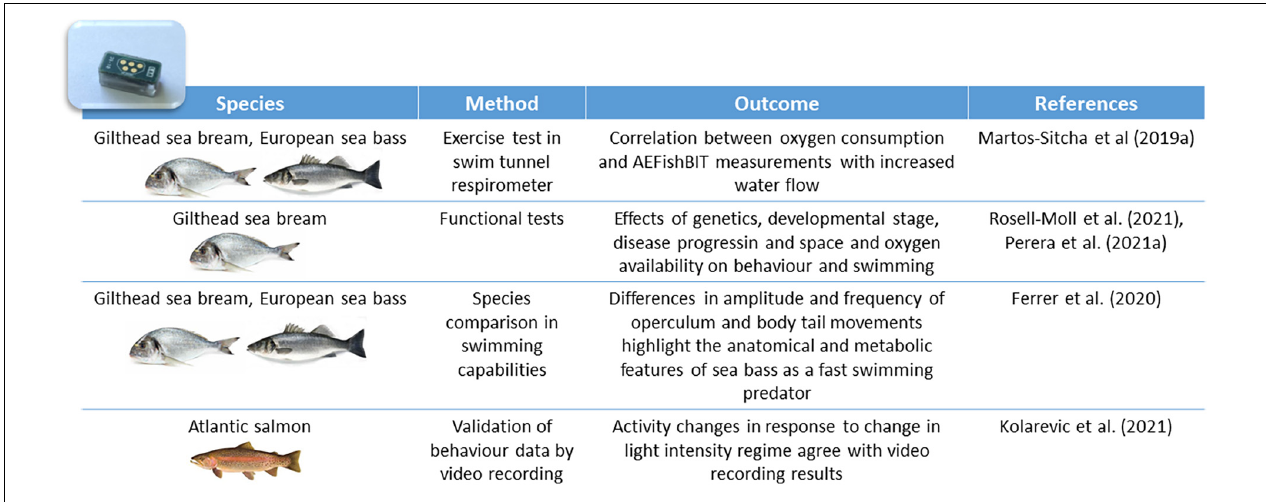
FIGURE 1 | AEFishBIT validation procedures